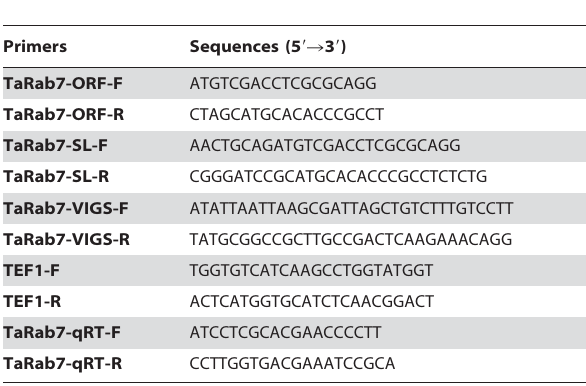
Table 1. PCR primers used for TaRab7 cloning, expression vector construction and qRT-PCR amplification.